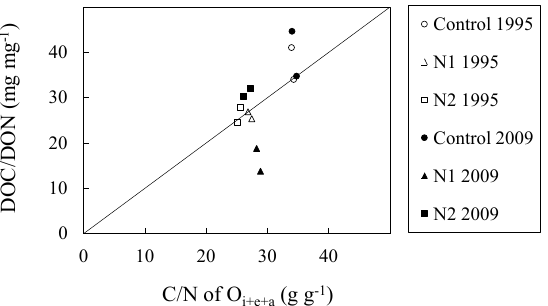
Fig. 3. Dissolved organic carbon/dissolved organic nitrogen, DOC/DON, (mgmg − 1 ) of annual means per plot in O horizon ZTL leachates and carbon/nitrogen, C/N, (gg − 1 ) of O i + e + a at Str˚asan. O i + e + a horizon carbon and nitrogen were determined in 1996 and 2010. Drawn line is the 1:1